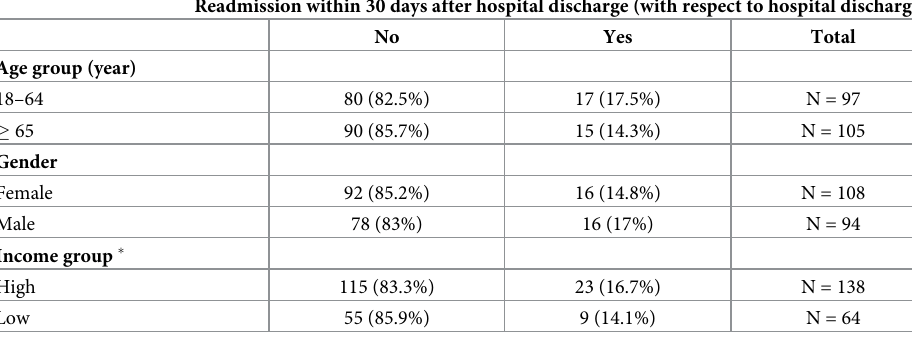
Table 1. Characteristics of the patients involved in the